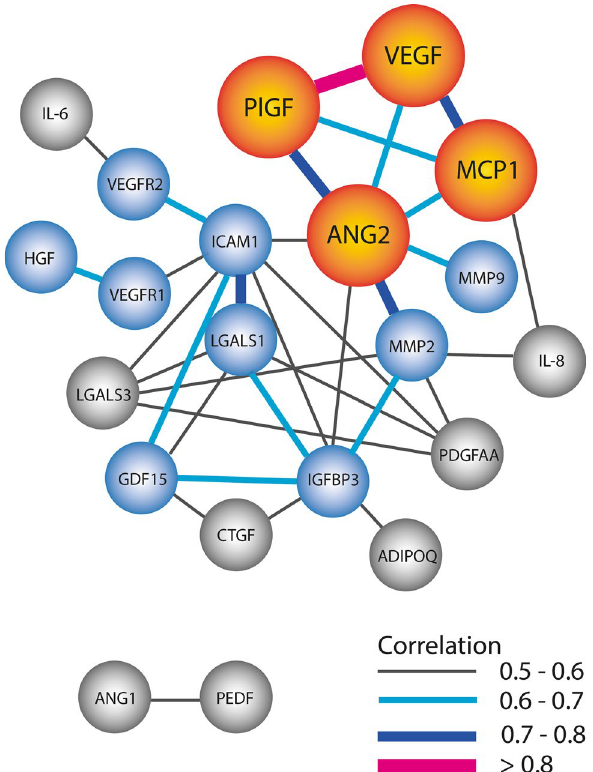
Figure 1. Co-regulation of proteins. Protein concentrations in the untreated PDR group were analysed using Pearson’s regression. This forms a network of proteins. Only correlations and proteins that had a correlation coefficient higher than 0.4 and P value < 0.01 are shown. Orange indicates the proteins that had the strongest correlation with other proteins; blue circles had at least one correlation > 0.6; grey: only moderate correlations. Line thickness indicates the strength of the correlation, with correlation coefficients between 0.4 and 0.5 being moderate and > 0.6